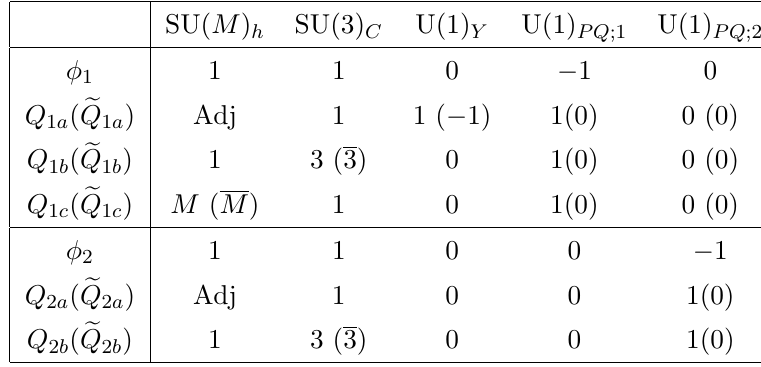
Table 1 . Particle content of a bi-axion alignment